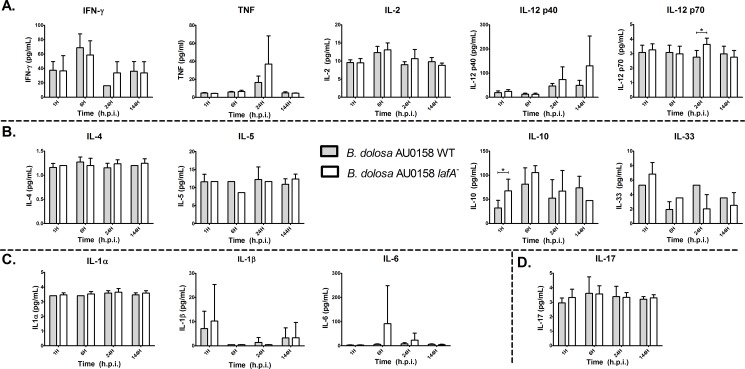
Cytokine expression in the murine lung during infection with B. dolosa wild-type or lafA deletion mutant strains.Cytokines belonging to the Th1 response pathway (panel A), Th2 pathway (panel B), innate/acute immunity (panel C), and the Th17 pathway (panel D) were collected from the BAL fluid from 3–5 mice and measured using Luminex protocols. Gray bars represent B. dolosa AU0158 wild-type strain and the white bars represent the B. dolosa AU0158 lafA deletion mutant strain. Error bars represent one standard deviation. Significance was assessed by unpaired t-tests between strains at each time point. An asterisk indicates a p-value < 0.05.